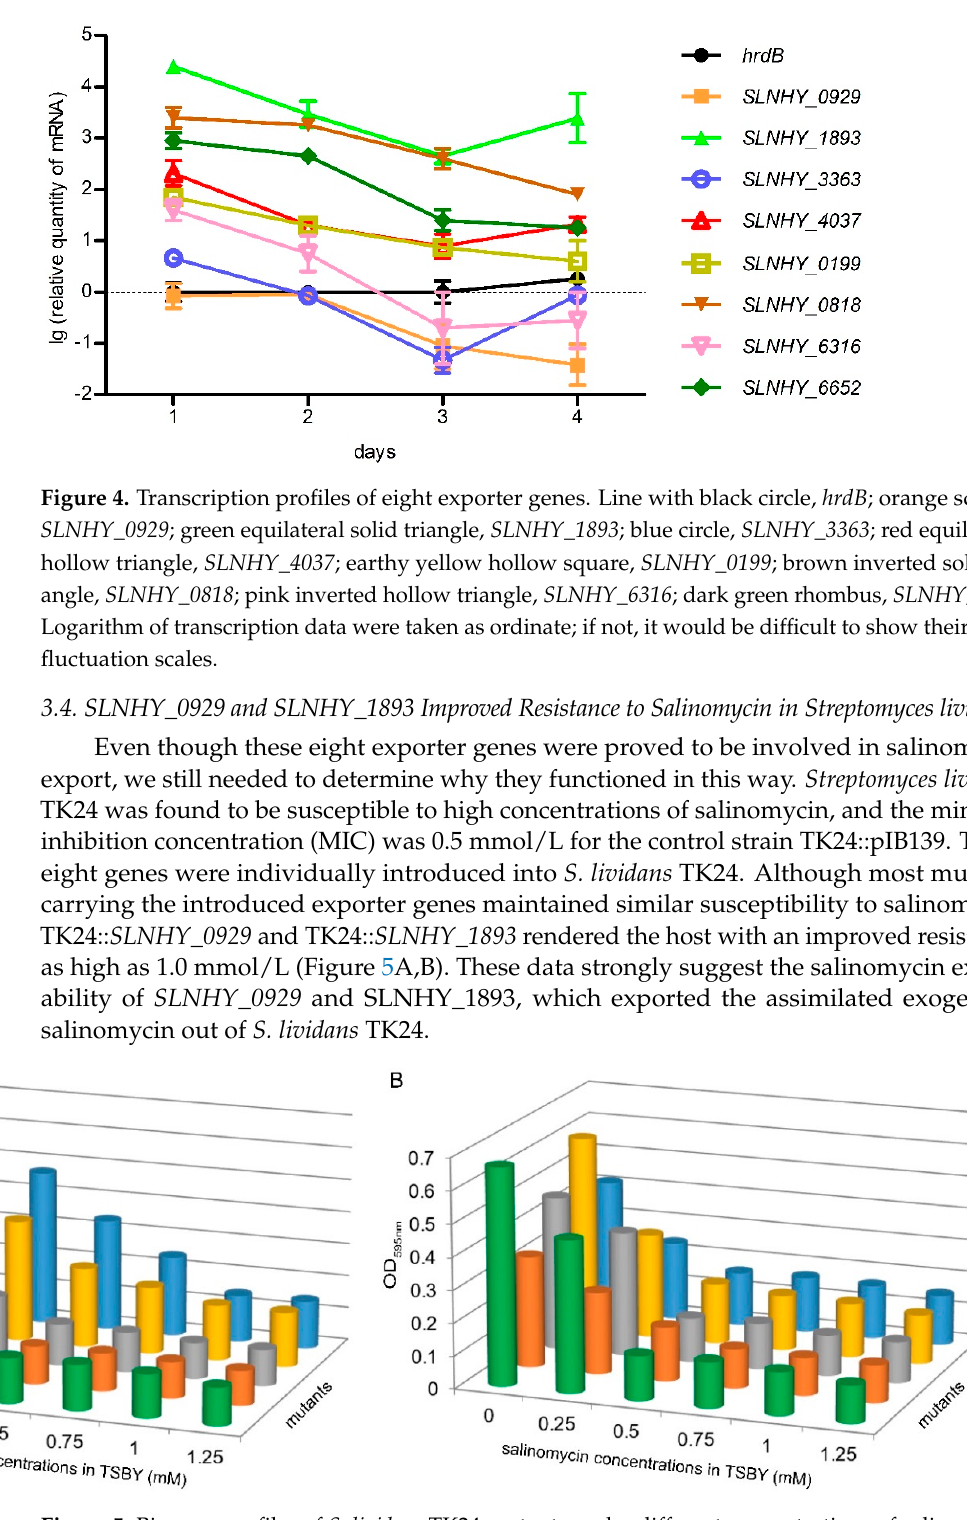
Figure 5. Biomass profiles of S. lividans TK24 mutants under different concentrations of salinomycin. Total intracellular nucleic acid was determined to represent the growth of S. lividans . ( A ) Green column, TK24::pIB139; orange column, TK24:: SLNHY_3363 ; gray column, TK24:: SLNHY_4037 ; yel- low column, TK24:: SLNHY_0929 ; blue column, TK24:: SLNHY_1893 . ( B ) Green column, TK24::pIB139; orange column, TK24:: SLNHY_0199 ; gray column, TK24:: SLNHY_0818 ; yellow col- umn, TK24:: SLNHY_6316 ; blue column, TK24:: SLNHY_6652